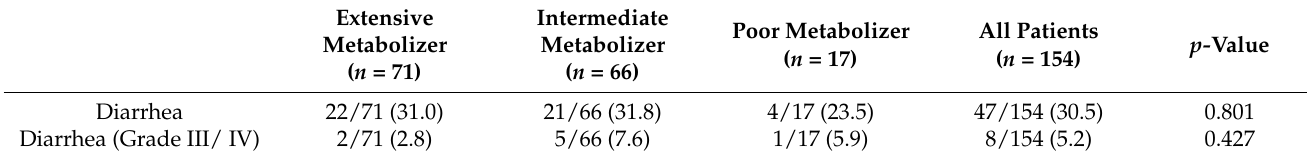
Table 8. Incidence of diarrhea according to UGT1A1 phenotype.